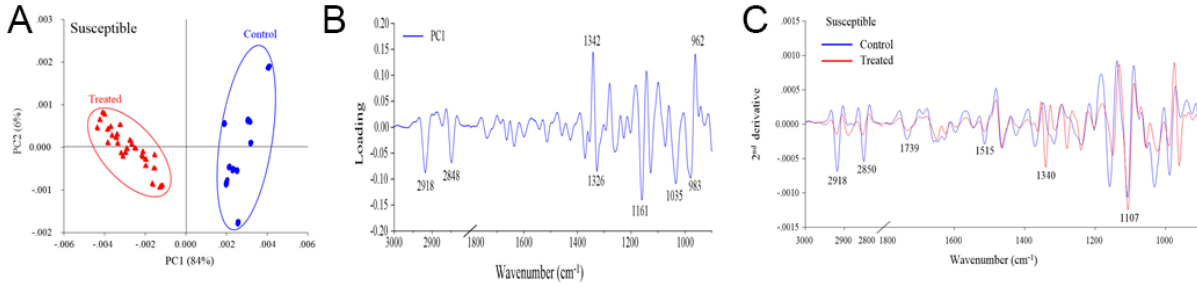
Figure 2 ( A ) Representative PCA score plot of susceptible plants under drought stress conditions and control conditions. ( B ) Loading plot of PC1 from the PCA. ( C ) Second-derivative-transformed spectra. e obtained spectra were analyzed in the regions of 3,000–2,800 cm − 1 and 1,800–900 cm − 1 .